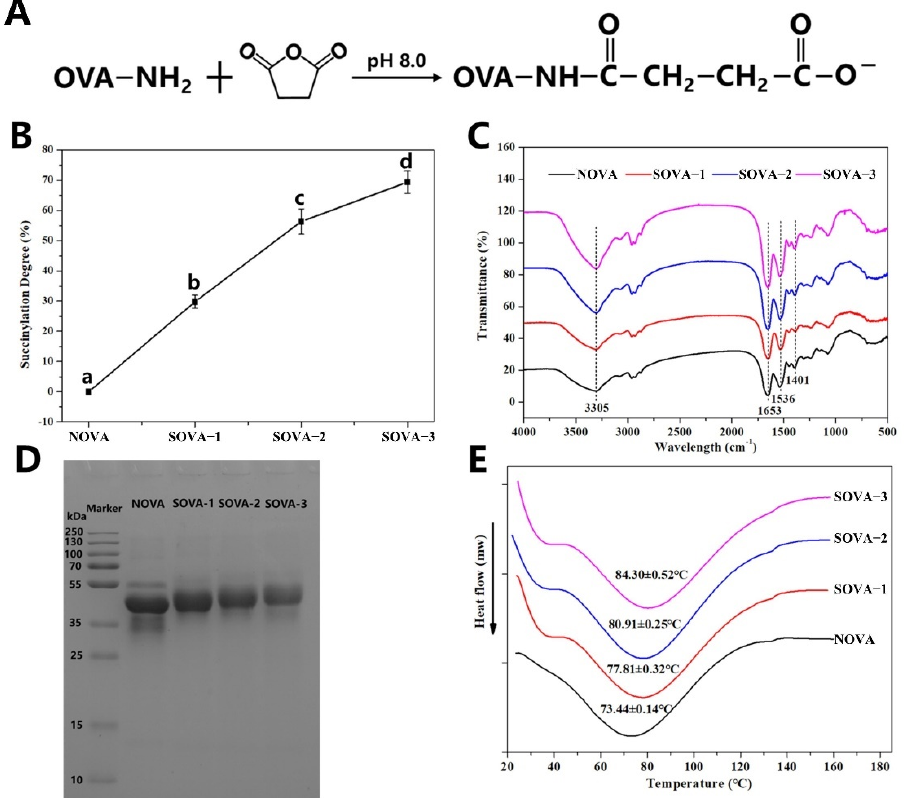
Figure 1. Nucleophilic substitution mechanism of OVA and succinic anhydride ( A ), succinylation degree ( B ), FTIR spectroscopy( C ), SDS − PAGE patterns ( D ), and DSC thermograms ( E ) of OVA with a different succinylated degree. Different letters indicate significant differences ( p < 0.05).